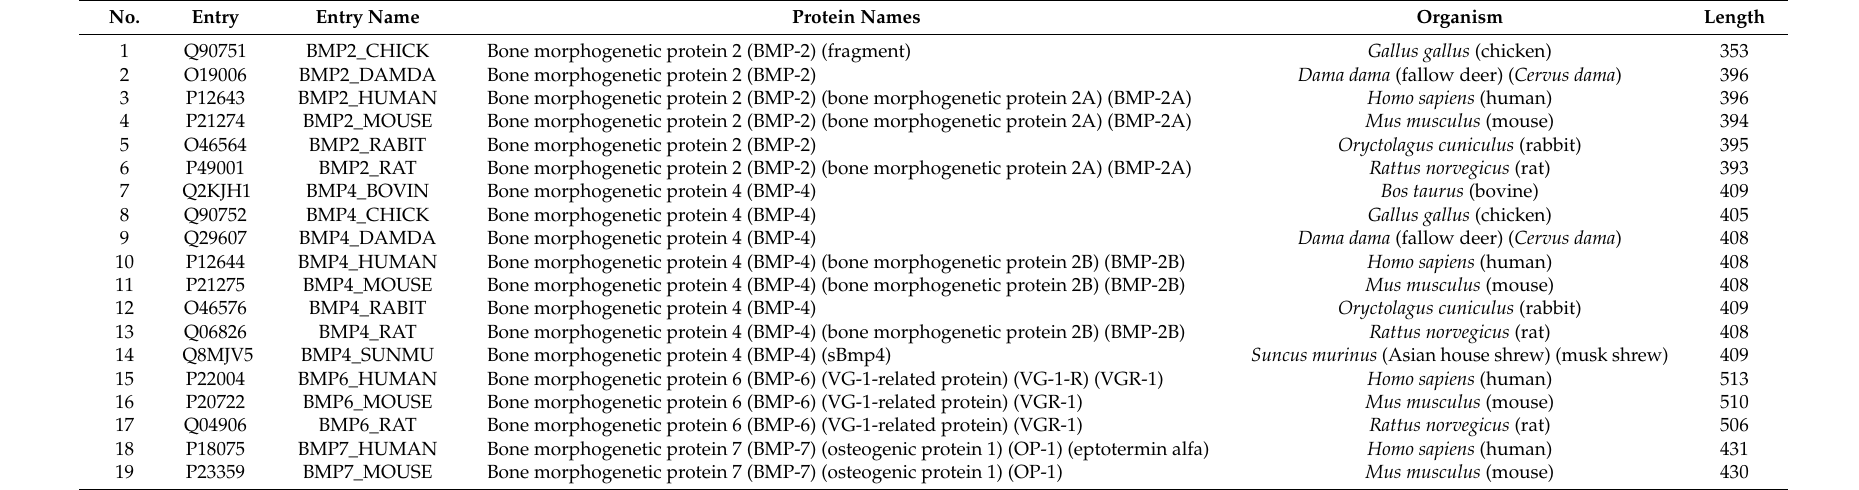
Table 1. BMPs used in alignment